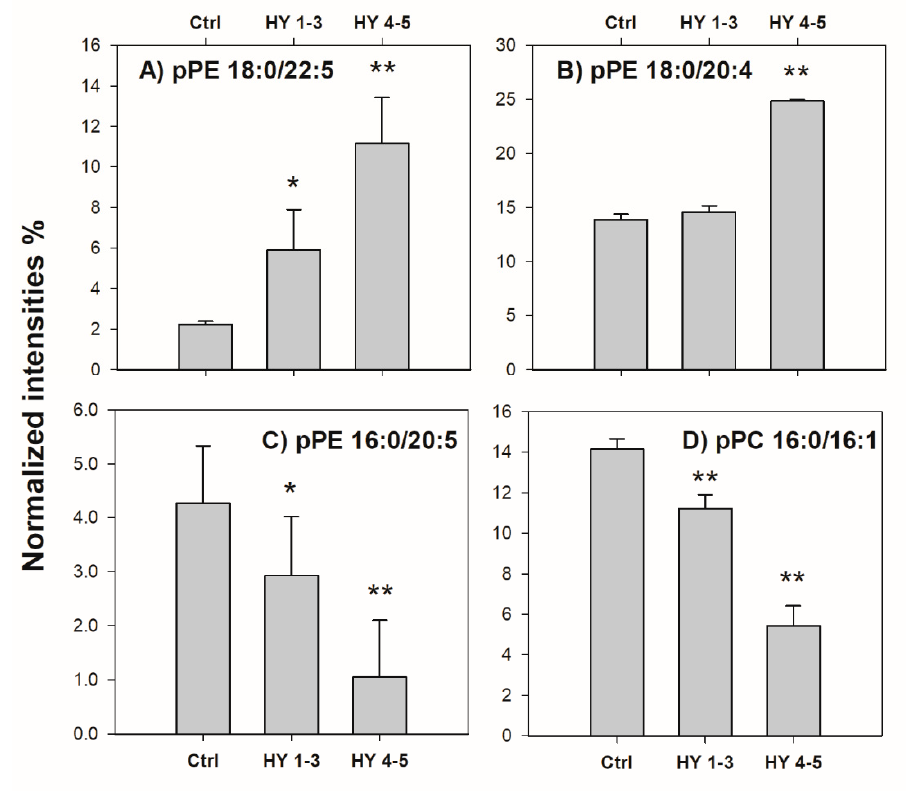
Figure 6. Bar plots of ( A ) pPE (18:0 / 22:5) at m / z 776.5, ( B ) pPE (18:0 / 20:4) at m / z 750.5, ( C ) pPE (16:0 / 20:5) at m / z 720.5 and D ) pPC (16:0 / 16:1) at m / z 700.5 obtained as normalized intensities (as described in the text) plotted versus pathology degree specified as ctrl (control), group HY 1-3 and group HY 4-5 (see Table 2). Data are reported as average values on three independent replicates for each sample; error bars represent standard deviations. Bars marked with asterisks represent normalized intensities significantly di ff erent from those of the control group (* p < 0.05; ** p < 0.01), as assessed using a nonparametric Welch’s two tails t -test.